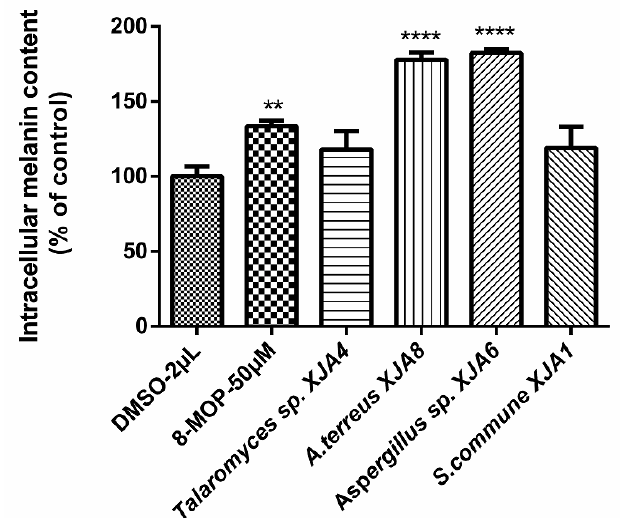
Figure 3. E ff ect of secondary metabolites of endophytic fungi on melanin production in B16 Figure 3. Effect of secondary metabolites of endophytic fungi on melanin production in B16 cells, (** p cells, (** p value < 0.01, while **** p values < 0.0001, compared with the dimethyl sulfoxide value ˂ 0.01, while **** p values ˂ 0.0001, compared with the dimethyl sulfoxide (DMSO)-treated (DMSO)-treated control).